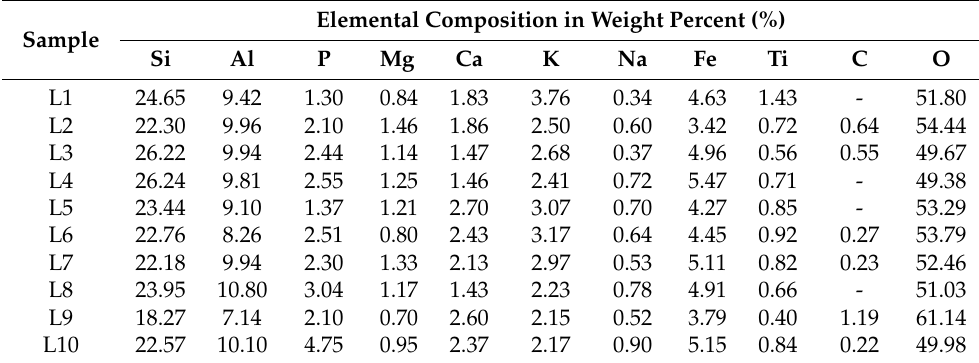
Table 1. Elemental composition of the ceramic fragments from the Piatra Neamt